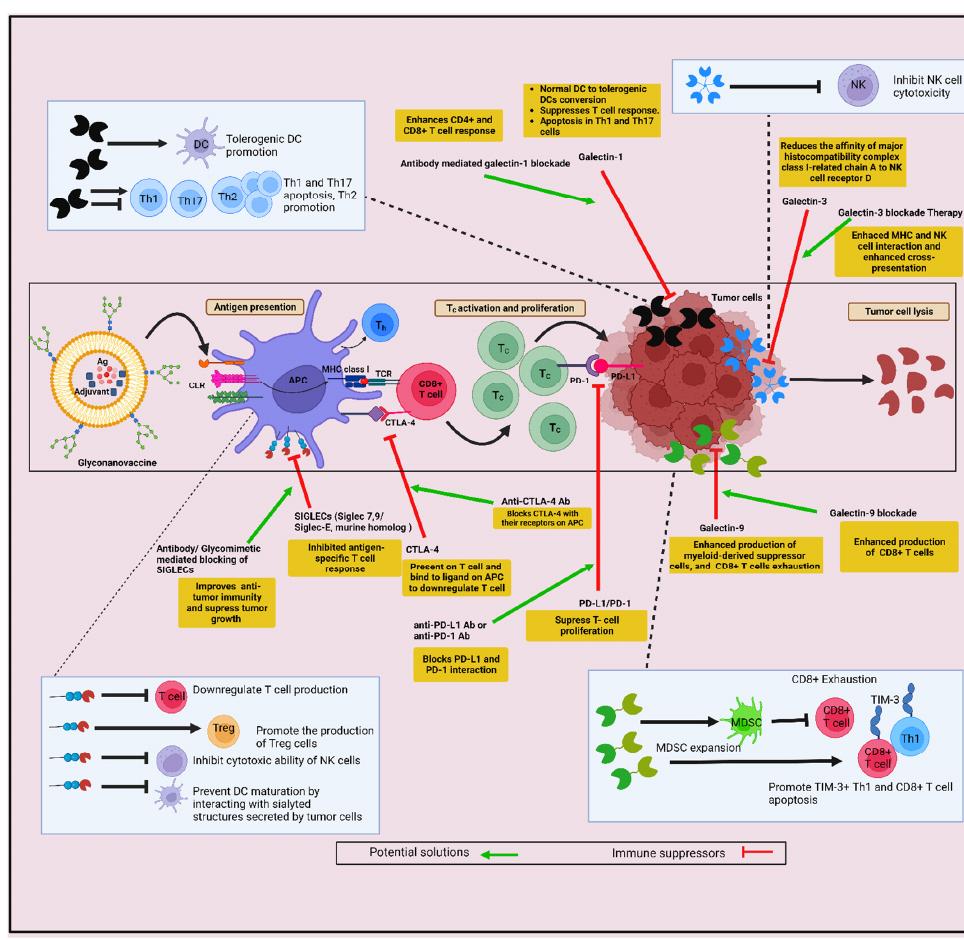
Figure 4. Strategies to enhance the anti-tumor response of glyconanovaccines (GNVs). Generation of a large number of tumor antigen-specific T response will be induced through the injection of GNVs to the skin DCs. Targeting of the GNVs to the specific DC subset is achieved by surface mod- ification with specific glycans to target CLRs on DCs for the internalization and subsequent tumor antigen presentation and maturation of DCs. This leads to the priming and activation of T cells that are specific for tumor-antigens, creating a large pool of effector cytotoxic T cells that are capable of moving toward tumors, penetrating them, and ultimately killing tumor cells once they have been recognized. The anti-tumor response will be enhanced by the administration of checkpoint inhibi- tors, such as anti-CTLA-4, anti-PD-1 antibodies, glycomimetic/anti-Siglec antibodies, and further inhibition of galectins (galectin-1, -3, and -9). (Created with BioRender.com accessed on 27 Septem- ber 2022).